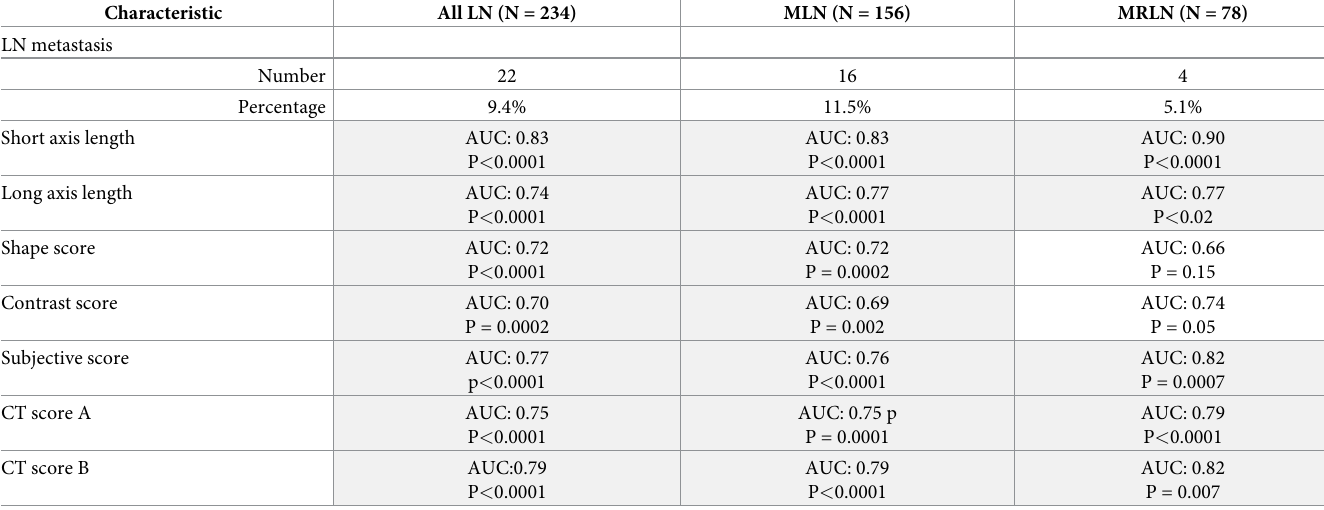
Data for all lymph nodes, mandibular lymph nodes (MLN) alone, and medial retropharyngeal lymph nodes (MRLN) alone are shown with corresponding P-values and area under the curves (AUC). Significant values are shaded light